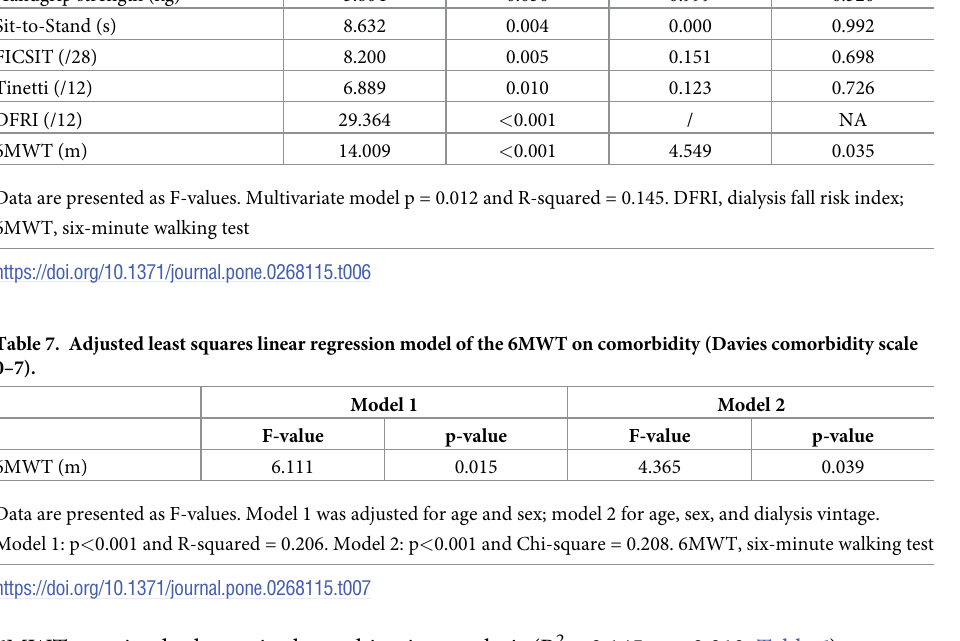
Data are presented as F-values. Model 1 was adjusted for age and sex; model 2 for age, sex, and dialysis